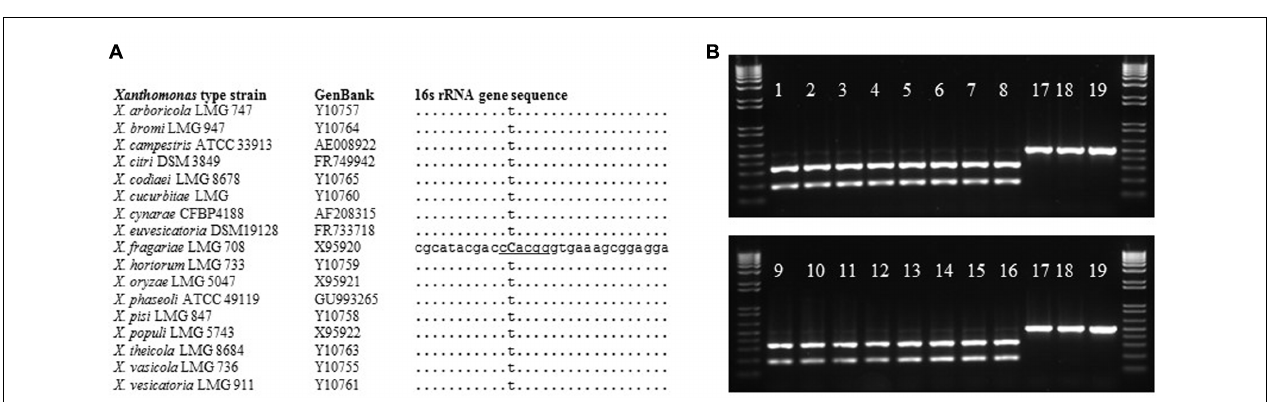
FIGURE 2 | Btg I-based identification of X. fragariae . (A) : alignment of partial 16 s rRNA gene sequences from Xanthomonas type strains, showing the unique cytosine (bold and capitalized) and Btg I recognition site (underlined) for X. fragariae . (B) : banding pattern following Btg I-digestion of pA-518r amplicons from